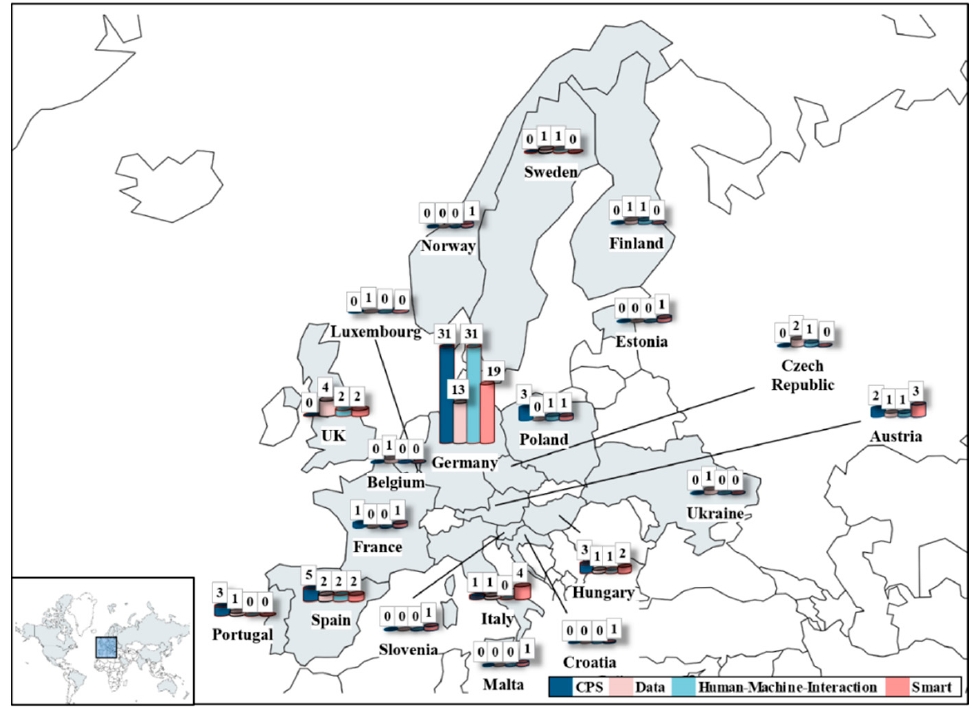
Figure 8. Papers identified in the correlated international analysis (European scale). Sources of the shapefile [38,39].